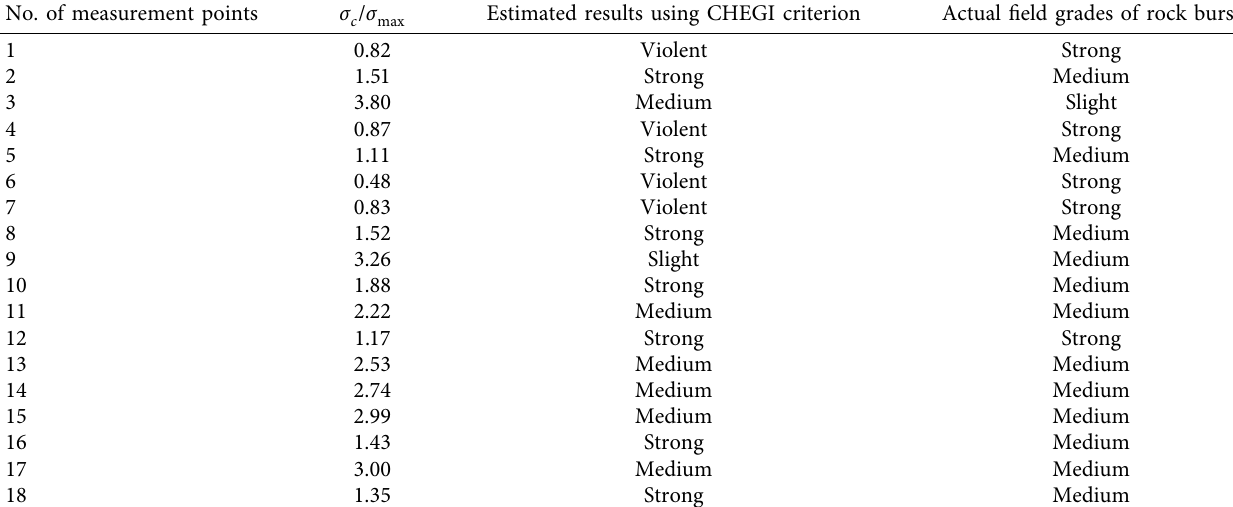
Table 4: Rock burst grades at various measurement locations using the ratio of σ